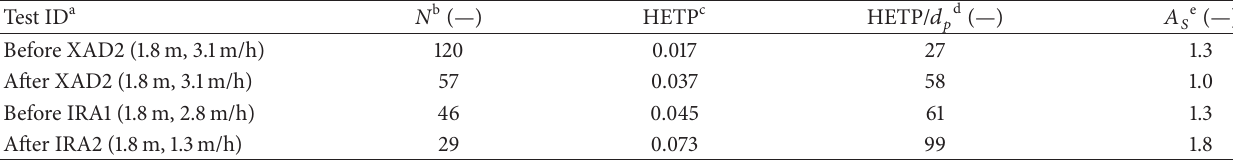
Table 5: Packing quality assessment on the basis of the fluid-dynamic tests.